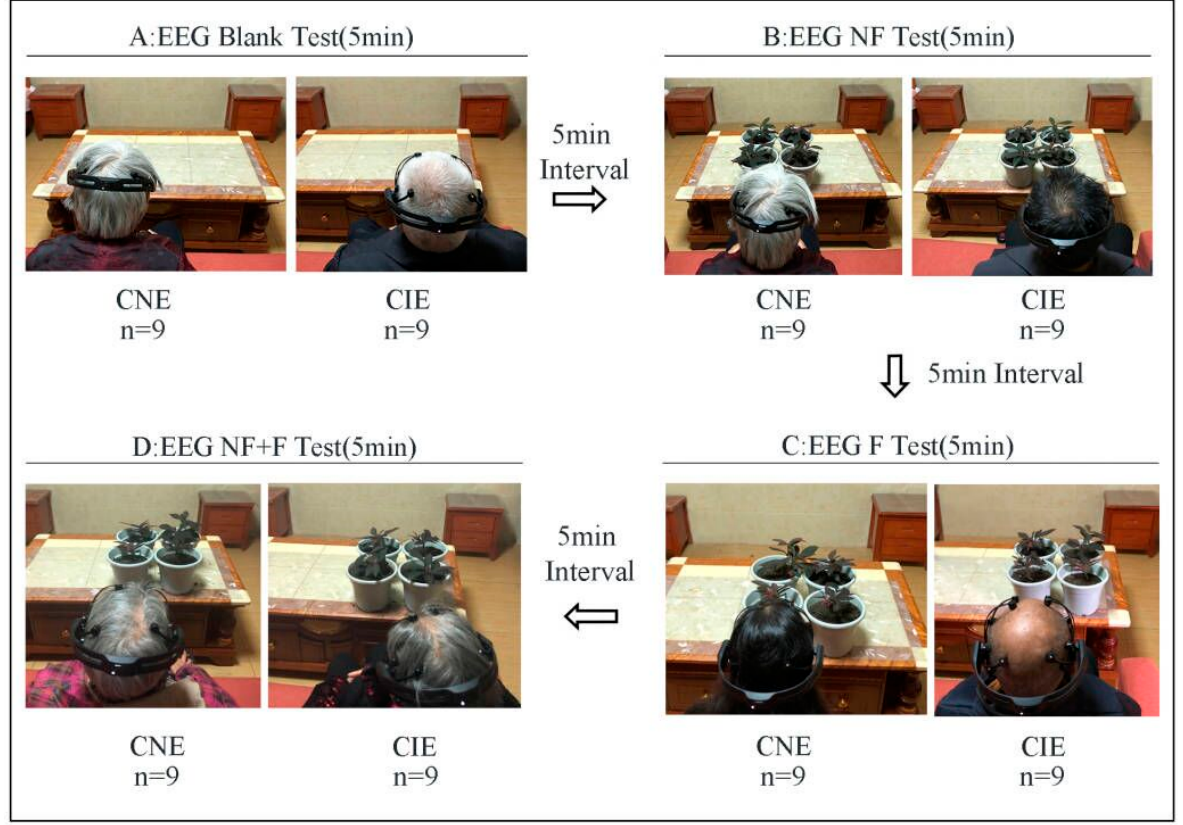
Figure 3. Study procedure ( A ): EEG Blank Test. ( B ): EEG NF Test. ( C ): EEG F Test. ( D ): EEG NF + F Test.